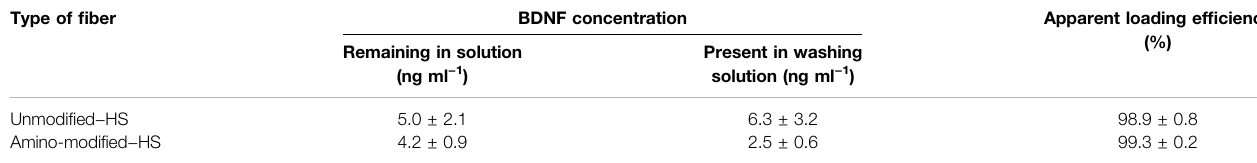
TABLE 2 | Quanti fi cation of the amount of immobilized BDNF on unmodi fi ed and amino-modi fi ed fi bers coated with HS which were incubated in a solution containing 1 μ g ml − 1 BDNF. Type of fi ber